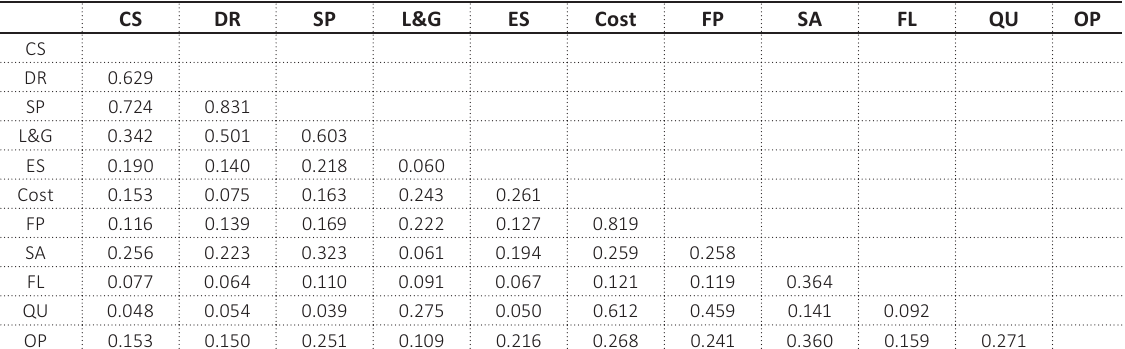
Table 4. Discriminant validity